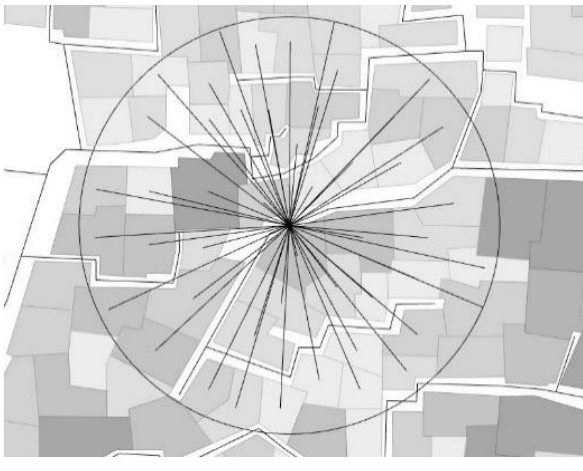
Figure 9. One distribution point outreach.